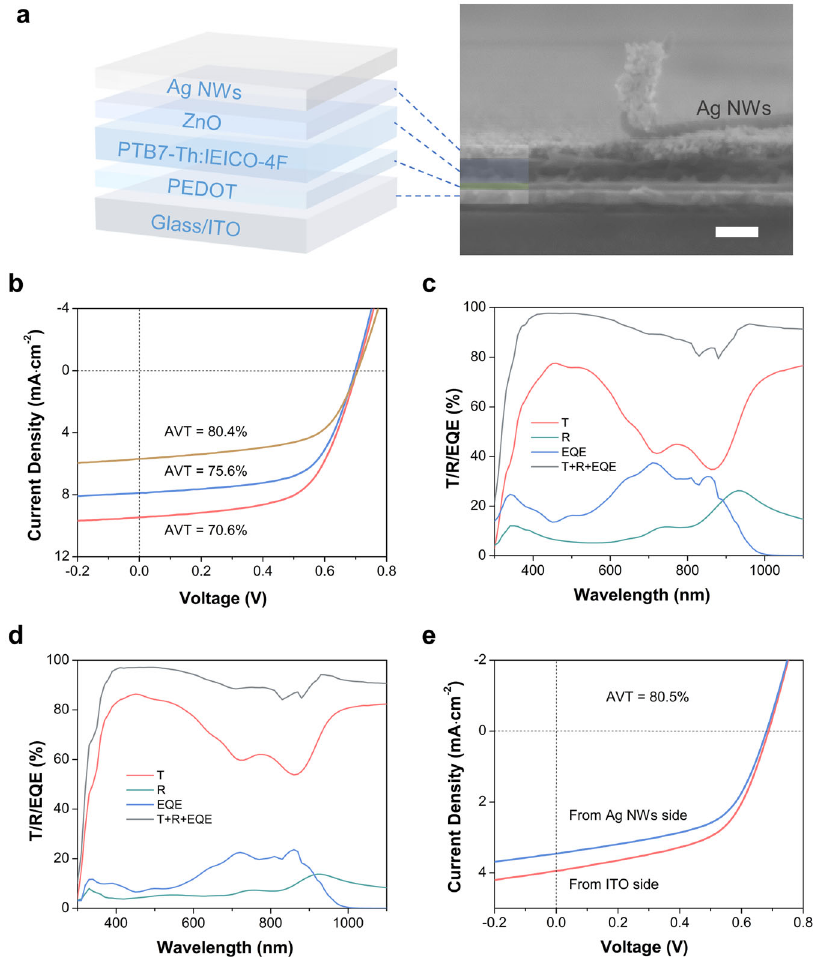
Fig. 3 Photovoltaic and optical properties of the TPVs. a Architecture and cross-section scanning electron microscope (SEM) image of the TPV devices (the scale bar is 100 nm). b J – V characteristics for TPV with AVT of 70.6% (D:A = 1:1.5, precursor concentration = 15.5 mg/mL), 75.6% (1:2, 15 mg/mL) and 80.4% (1:1.5, 9 mg/mL), respectively. Transmission ( T ), re fl ection ( R ) and external quantum ef fi ciency (EQE) properties for the TPV devices with AVT of 70.6% ( c ) and 80.4% ( d ). e J – V curves for TPV with AVT of 80.5% from different illumination